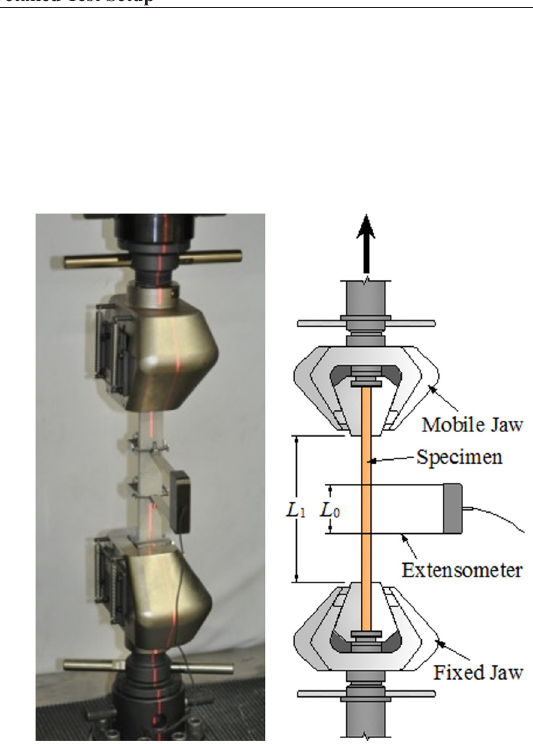
Table 2. Detailed information of performed test setups and corresponding expressions used to determine the mechanical properties. Test